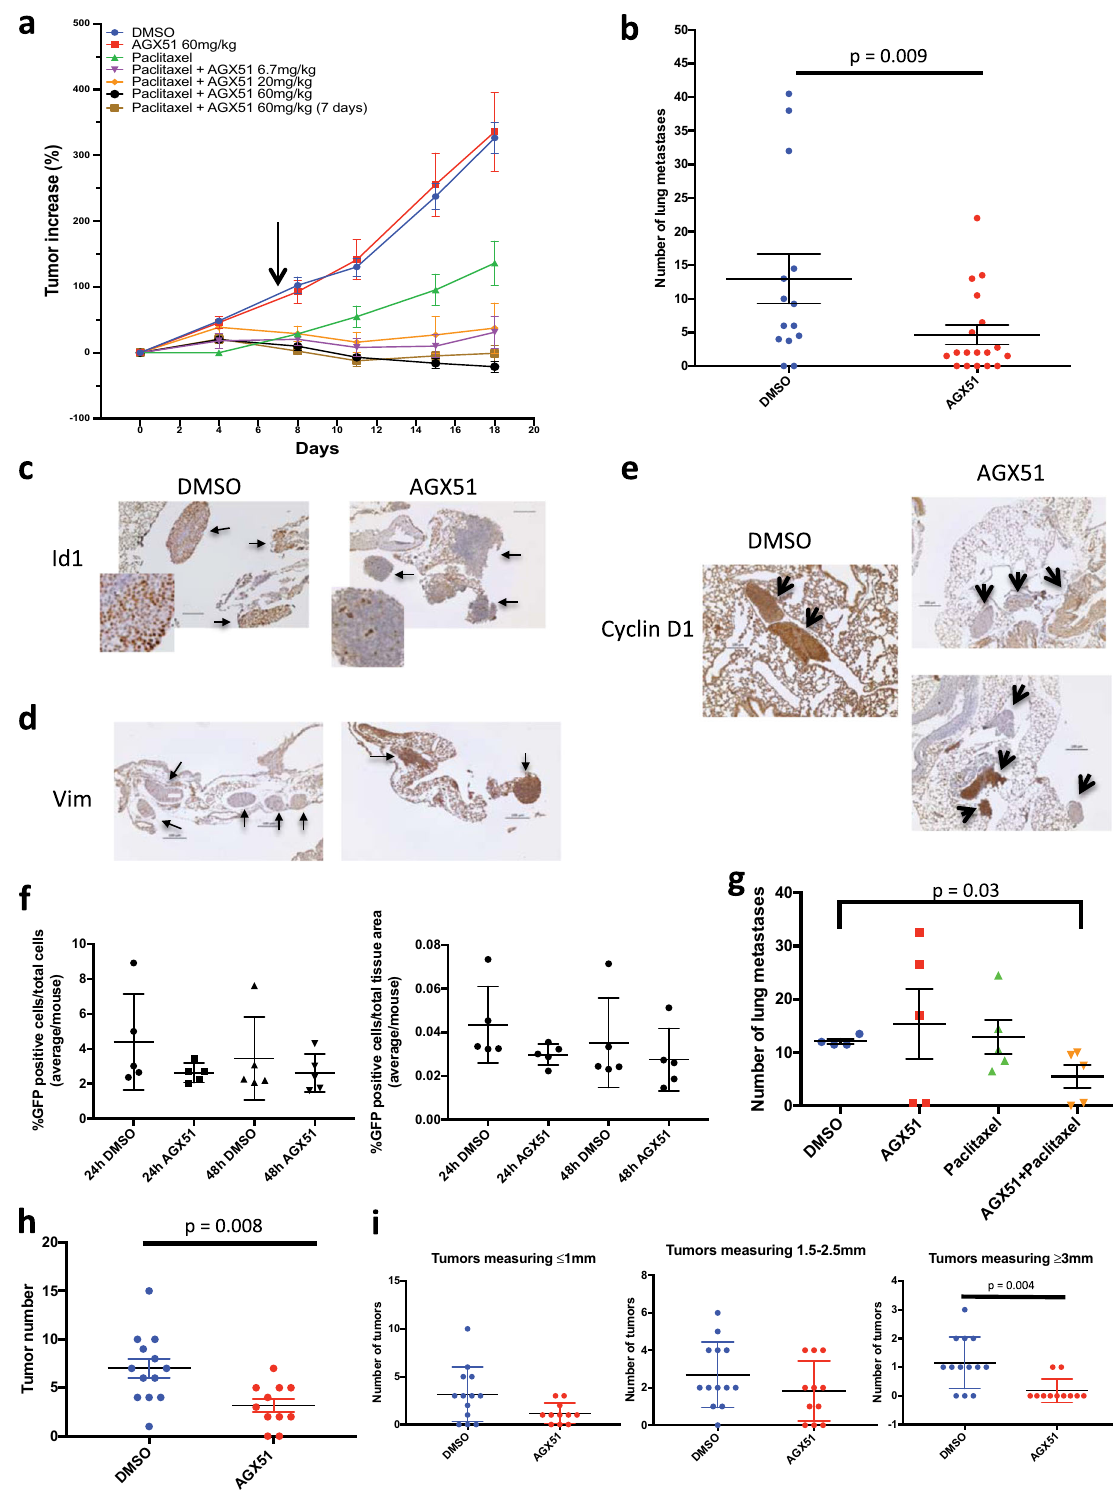
model using MDA-MB-231 cells with and without paclitaxel.